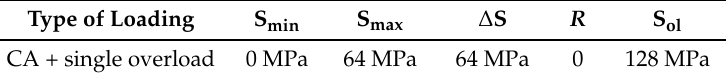
Table 9. Applied loading for D16 specimen.